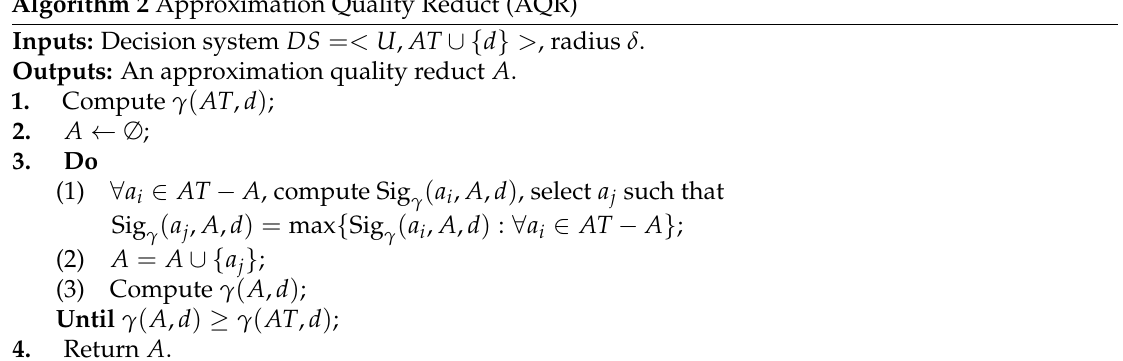
Algorithm 2 Approximation Quality Reduct